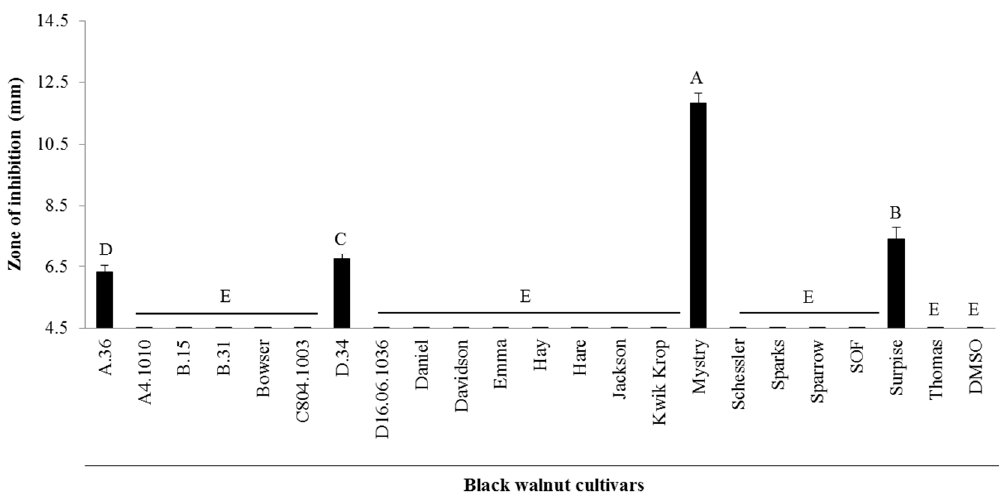
Figure 1. Zones of inhibition of crude kernel extracts of twenty-two black walnut cultivars grown in Missouri for Staphylococcus aureus . If no inhibition was observed in samples, a value of 4.5 mm, which was the diameter of the wells in agar-well diffusion experiments, was assigned. Means within bars followed by different letters are significantly different ( α = 0.05, ANOVA). Mean ± SEM.